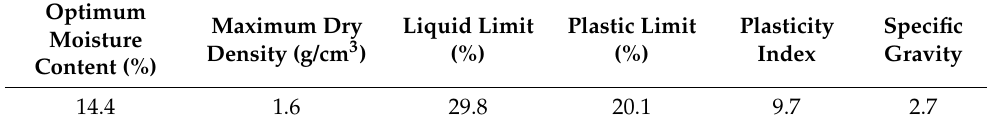
Table 1. Basic physical characteristics of silt.